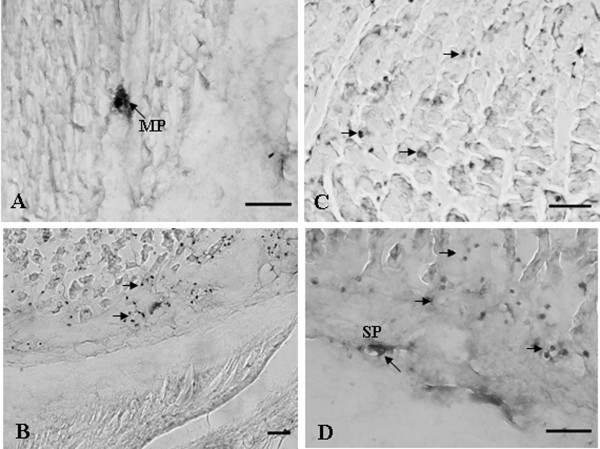
Immunohistochemical localization of cysteine sulfuric acid decarboxylase (CSAD) in the rat stomach. (A) Light micrography of a transverse section of the muscle layer showing CSAD-immunoreactive processes in the Body. (B) Light micrograph of cross section showing CSAD-positive processes in the antrum. (C) CSAD-immunoreactive cells occurred mostly in glands of the gastric mucosa. (D) CSAD-positive cell processes in the deep of mucosal layers. MP, myenteric plexus; SP, submucosa plexus. Arrowheads indicate CSAD-positive processes. Bar = 50 μm.